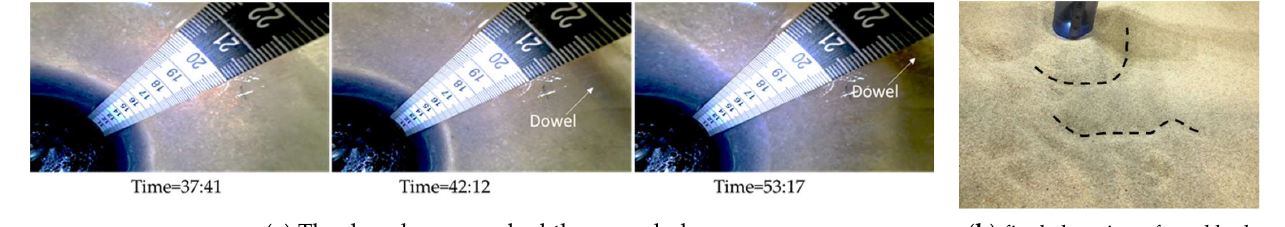
Figure 14. The debris jam reached the bed near the scour hole in test 5.